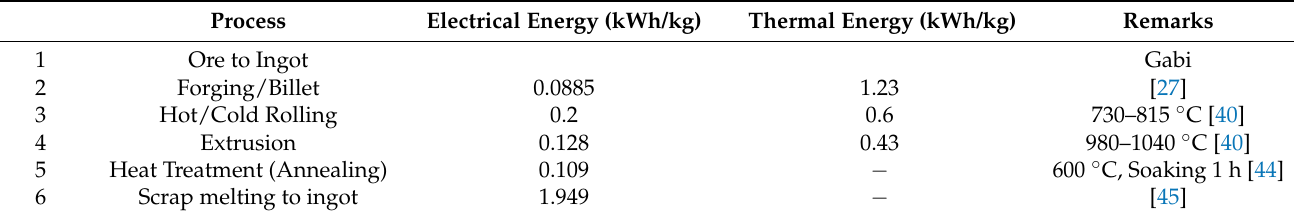
Table 2. Energy inputs for titanium-tube production.